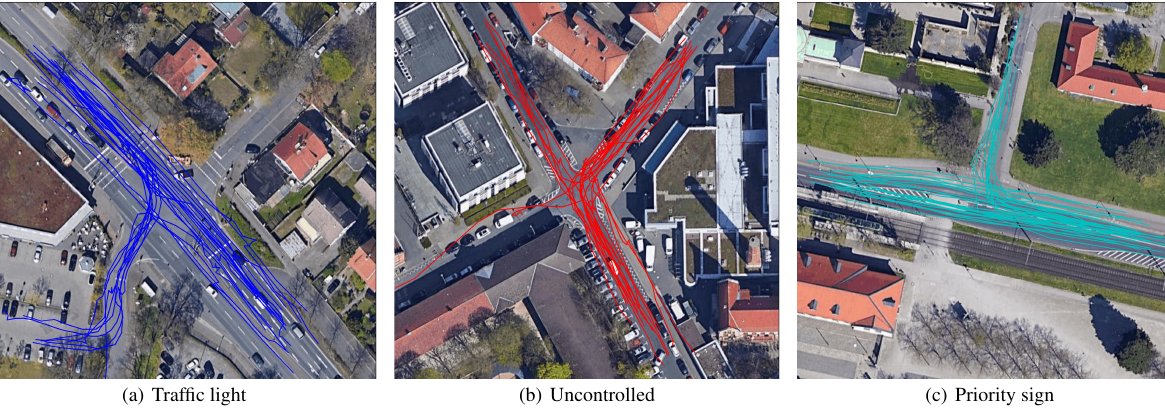
Figure 5. Intersections controlled by different arm rules with GPS